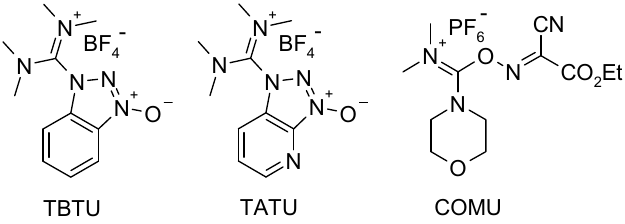
Figure 2. Structures of uronium-based compounds used to promote ester formation [134].